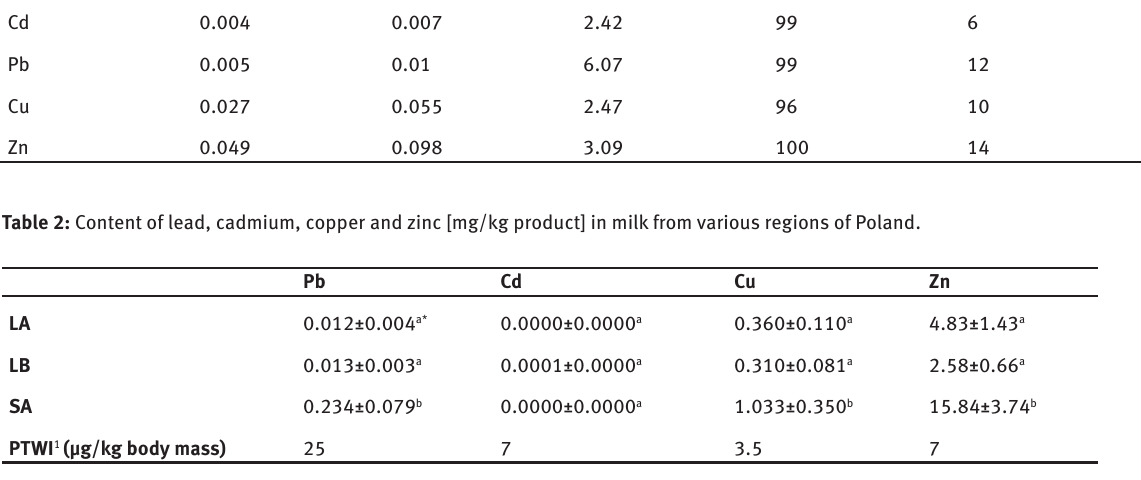
Table 1: Validation parameters applied during analysis. Element